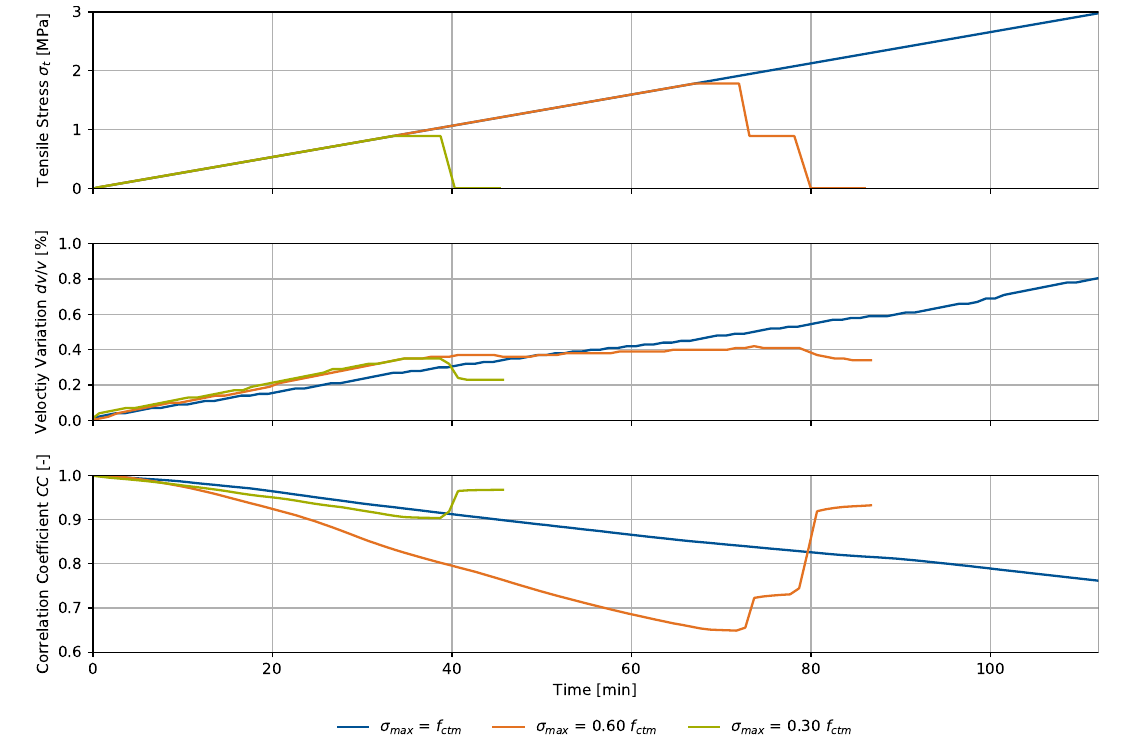
Figure 9. Uniaxial tension experiment for three specimens, referring to the setup in Figure 5 with different maximum stresses: tensile stress σ t , velocity variation dv / v and signal correlation coefficient CC over